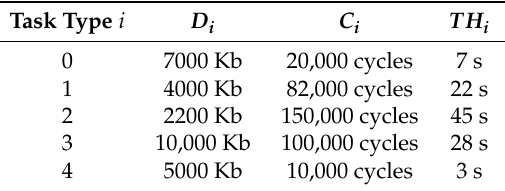
Table 2. The tasks in the smart